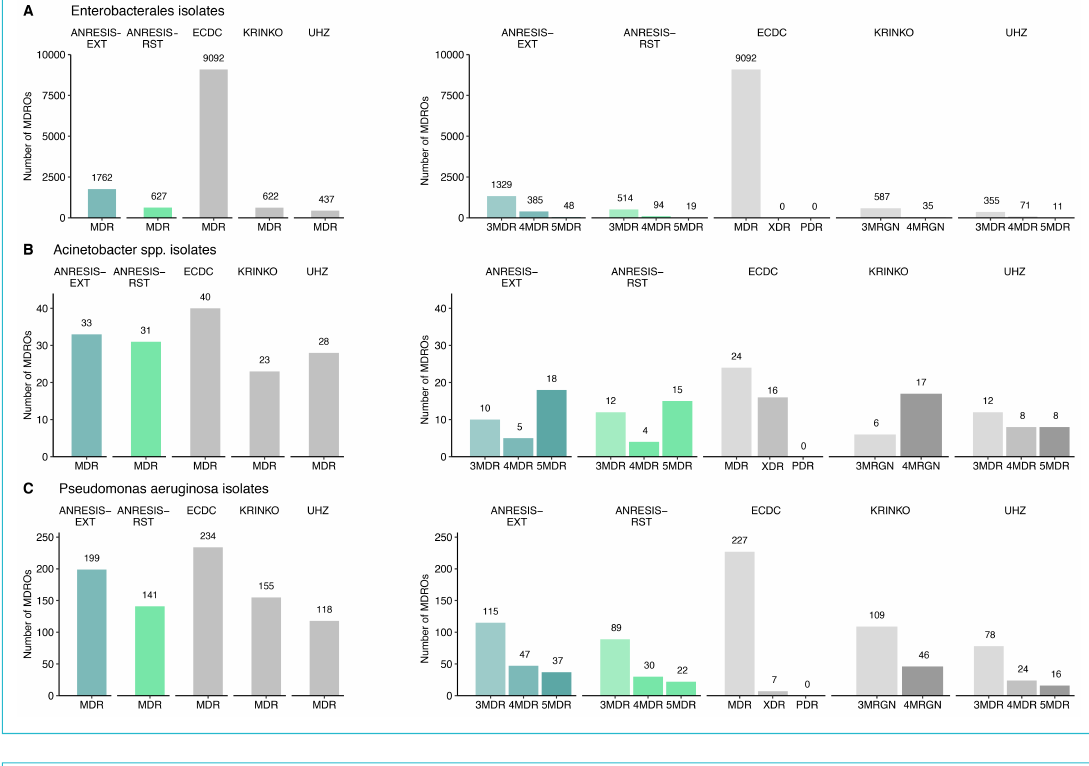
Figure 4: A) Overlap in the number of Enterobacterales isolates classified as MDR following the application of the KRINKO, UHZ and ANRE- SIS-RST definitions. B) Overlap in the number of Enterobacterales isolates classified as MDR after application of the ECDC and ANRESIS- EXT definitions and the combined MDR cases found with the KRINKO, UHZ and ANRESIS-RST definitions. MDR, multiple drug resistance; ECDC, European Centre for Disease Prevention and Control; KRINKO, Commission for Hospital Hygiene and Infection Prevention; UHZ, Uni- versity Hospital Zurich; ANRESIS, Swiss Centre for Antibiotic Resistance; RST, restricted; EXT,